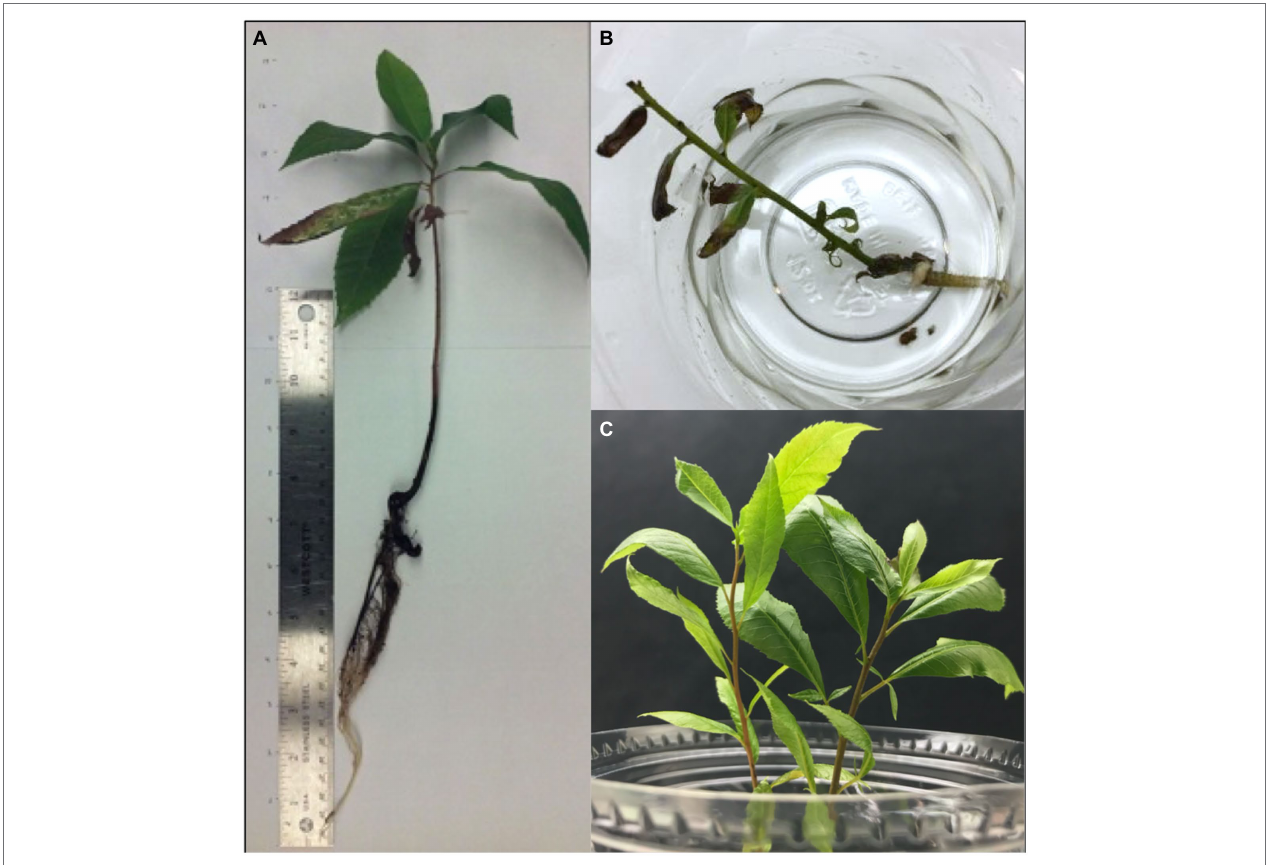
FIGURE 5 | Symptoms of PBLS caused by X. fastidiosa in seedlings. (A) and (B) Seedlings grown from NM pecan seeds exhibiting PBLS symptoms. (C) Healthy pecan seedlings.